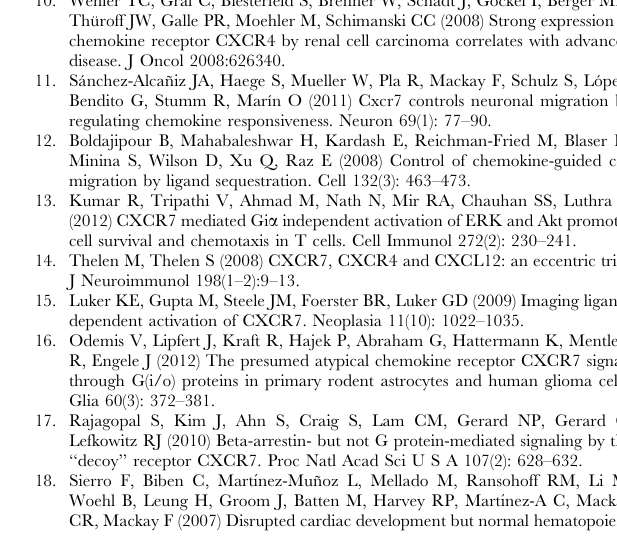
(closed arrowheads). Scale bar equals 100 m